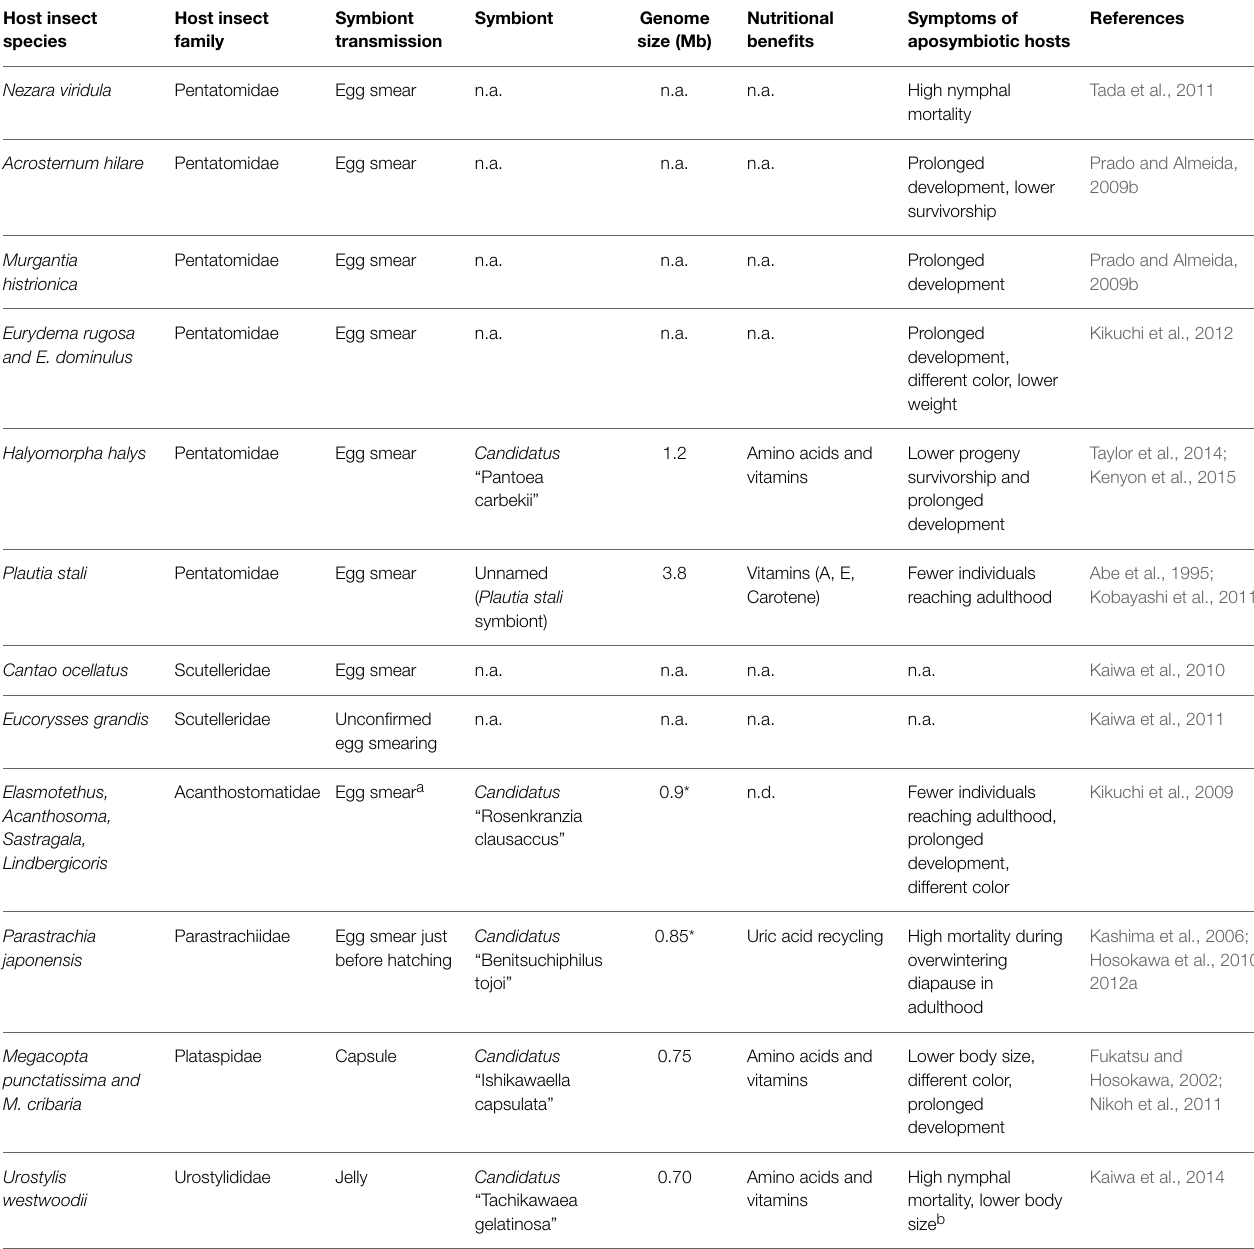
TABLE 1 | Summary of primary gammaproteobacterial gut symbionts of stink